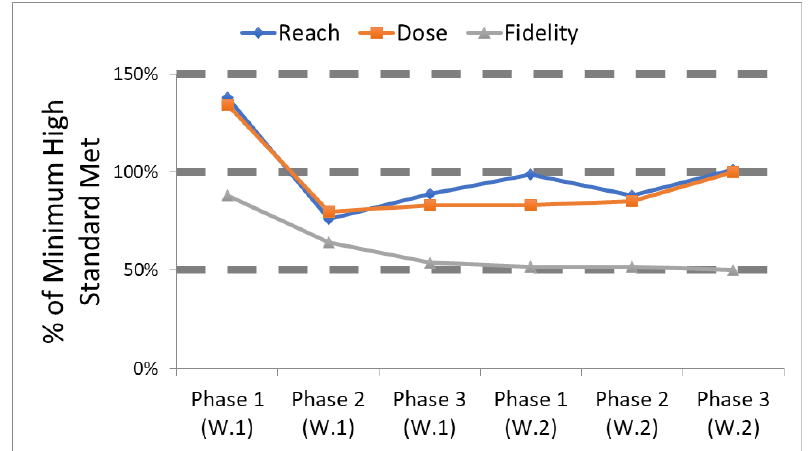
Figure 2. Tracking how well process evaluation standards were met for the youth leader component in B’More Healthy Communities for Kids. High (100%), medium (50%–99%) or low (<50%) refers to standards set a priori.